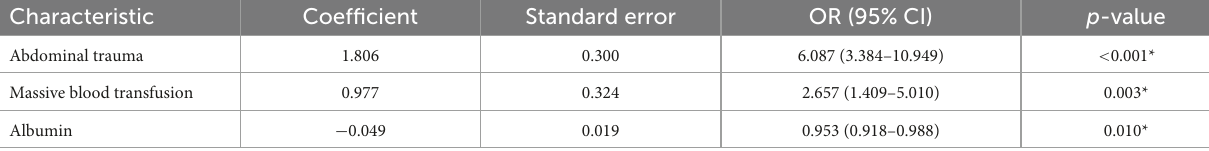
TABLE 5 Multivariable analysis of independent risk factors for delayed enteral